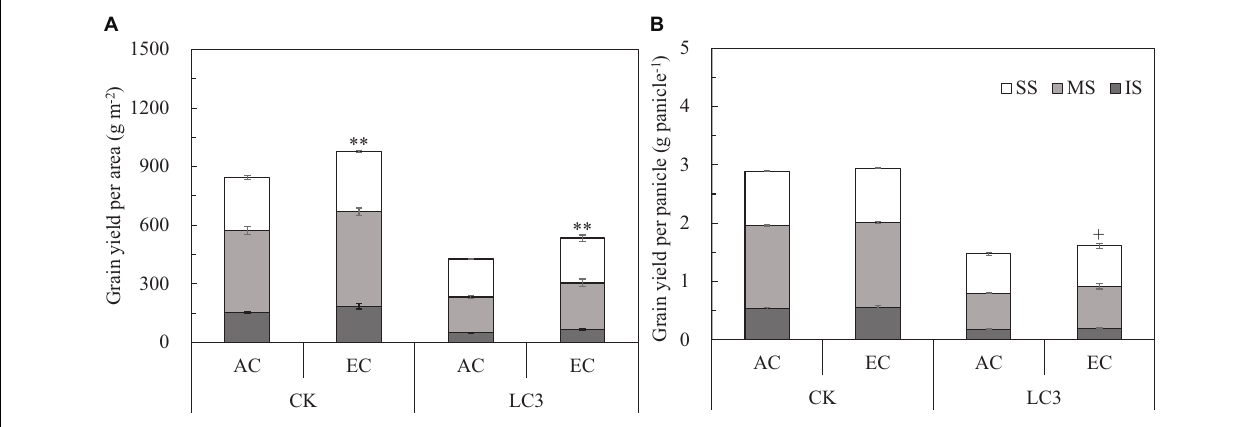
FIGURE 3 | Grain yield per area (A) and grain yield per panicle (B) of WYJ27 affected by elevated CO 2 and leaf-cutting treatment in 2018. Each bar in the figure represents the mean values across three plots for ambient CO 2 (AC) or elevated CO 2 (EC, AC + 200 ppm); vertical bars represent standard error ( n = 3). CK, no leaf cutting; LC3, cutting off top three leaves. P, grain position; SS, superior spikelet; MS, medium spikelet; IS, inferior spikelet. ** P < 0.01, + P < 0.1. TABLE 3 | Significance test for grain yield per area and per panicle of WYJ27 under elevated CO 2 and different source-sink treatments in 2018.